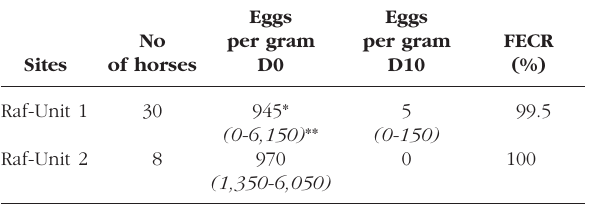
Table II. – Dichlorvos faecal egg count reduction test (FECR 10 days after treatment) in horses from two sites (33 mg/kg body weight)